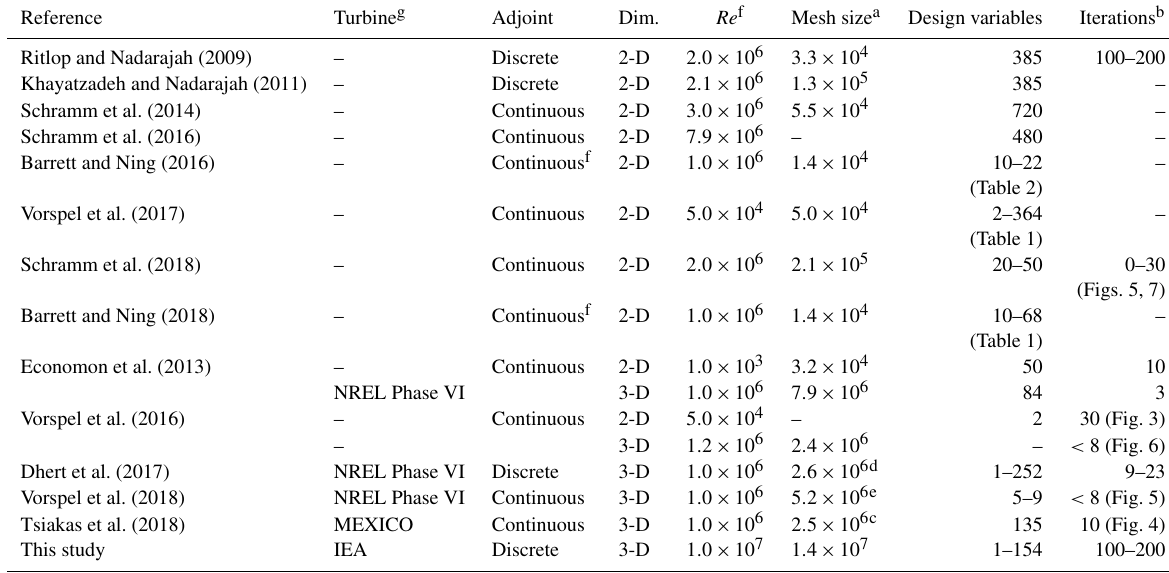
Table 1. Overview of related work using the adjoint